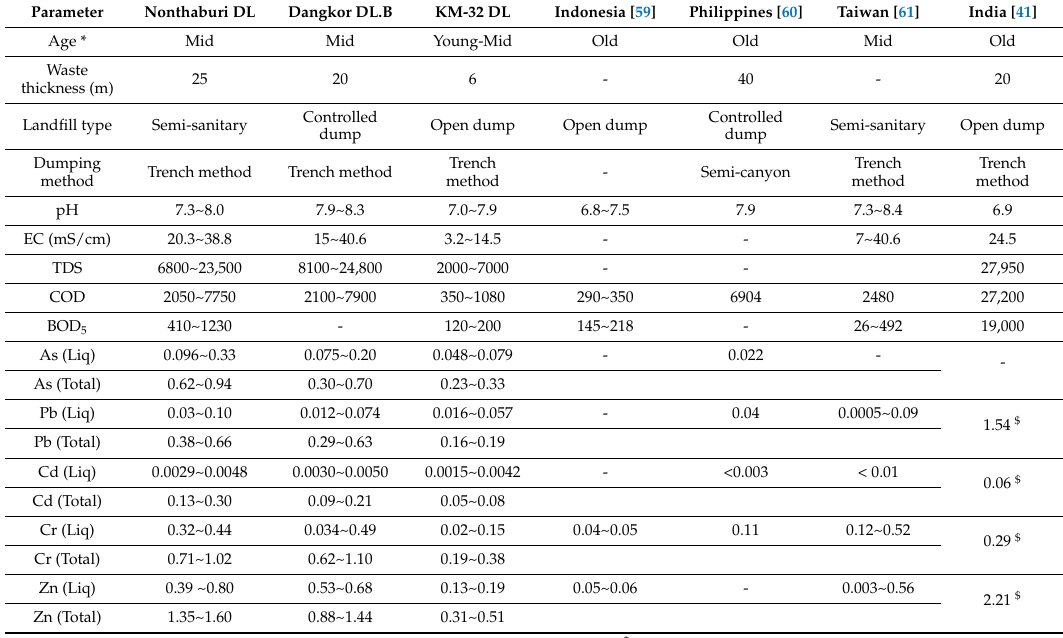
Table 3. Summary of the leachate quality of different landfills (units are in mg/L, unless specified). Parameter